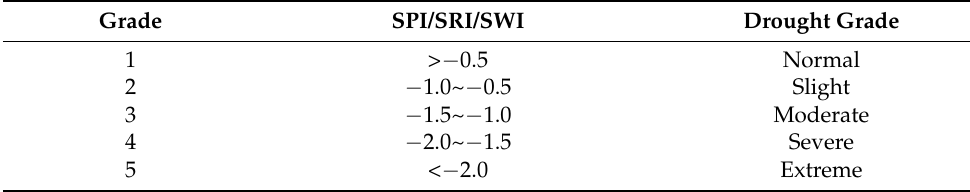
Moderate Severe